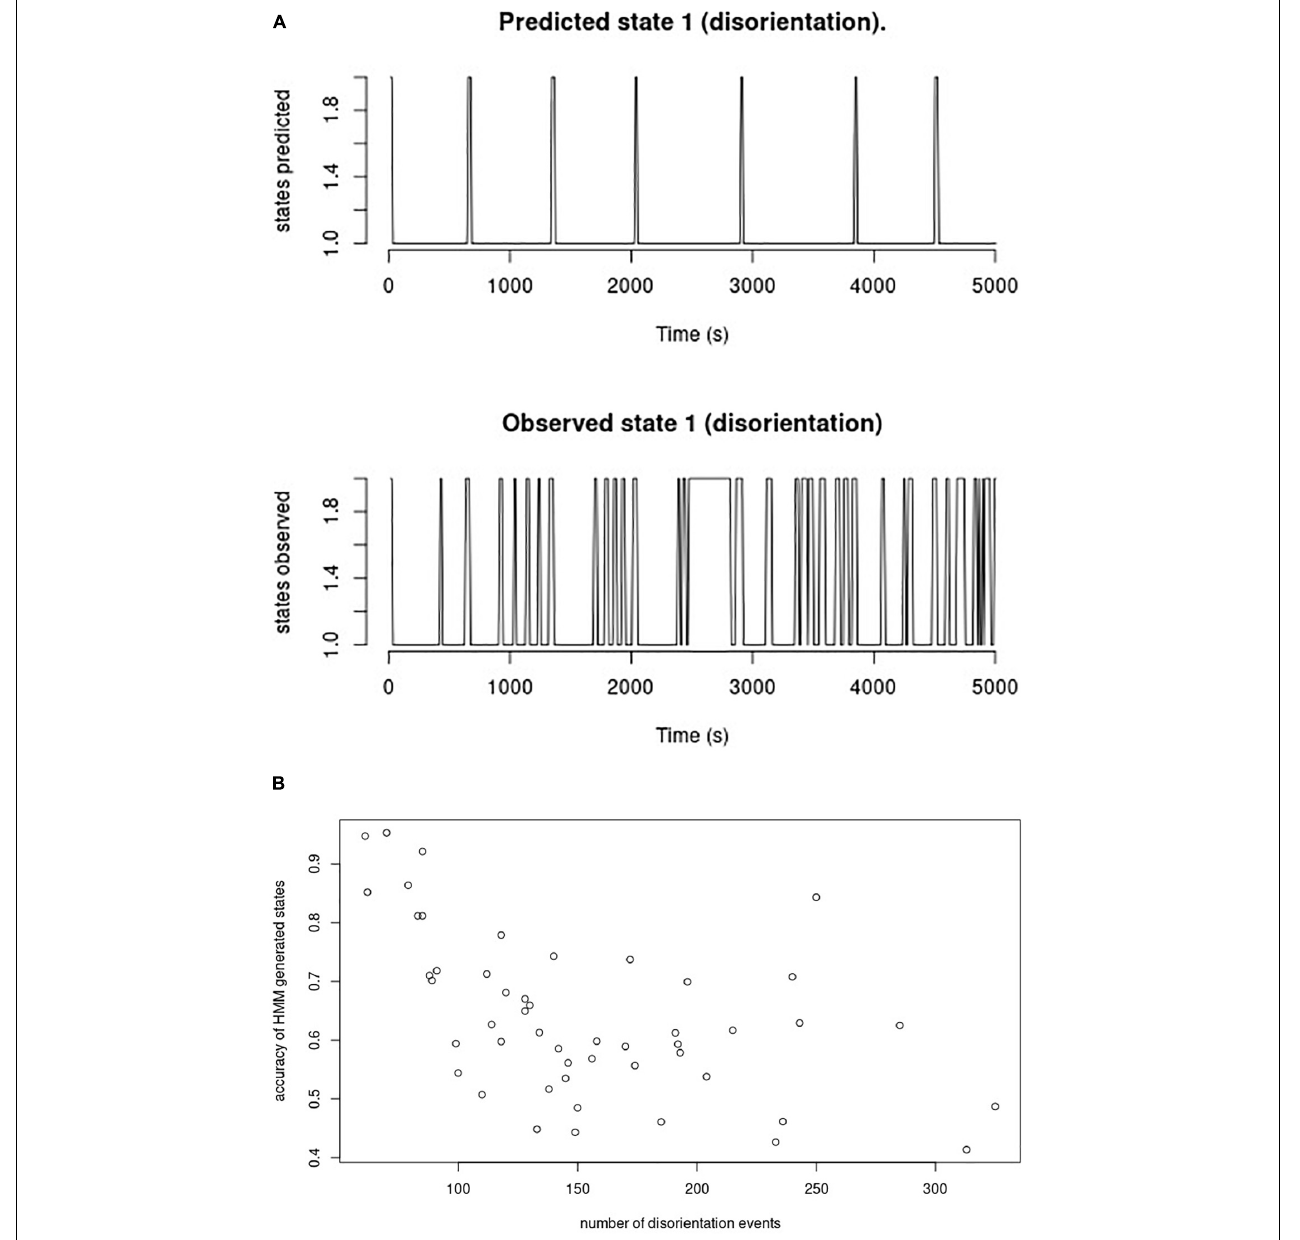
FIGURE 5 | Hidden Markov model generated states and observed orientation states. (A) Time series of states within 5,000 s. The upper row plots the orientation states generated from the Hidden Markov model during the first 500 time segments (= 5,000 s, pooled across participants) with 1 = oriented, 2 = disoriented; the lower row plots the observed orientation states from the same time segments. (B) Association between number of disorientation events and accuracy of HMM generated states. This graph plots the accuracy of the HMM generated states relative to the observed states per participant (y-axis) vs. the number of disorientation events per participant